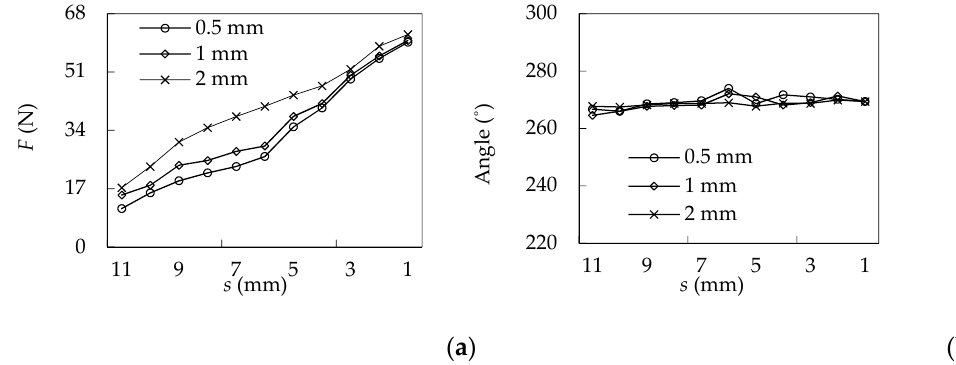
Figure 17. The effect of the bottom size of the sub-triangular NMC on EF: ( a ) the amplitude curve; ( b ) the phase curve.